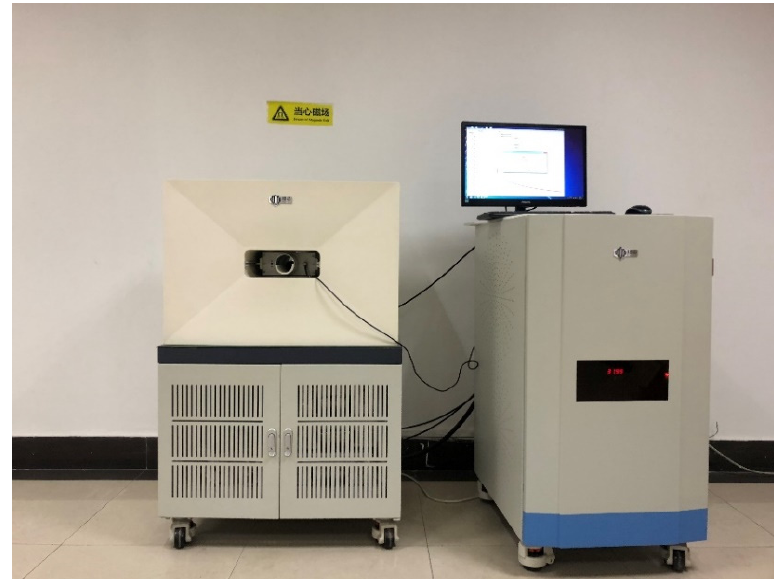
Figure 3. Photograph of the NMR device.